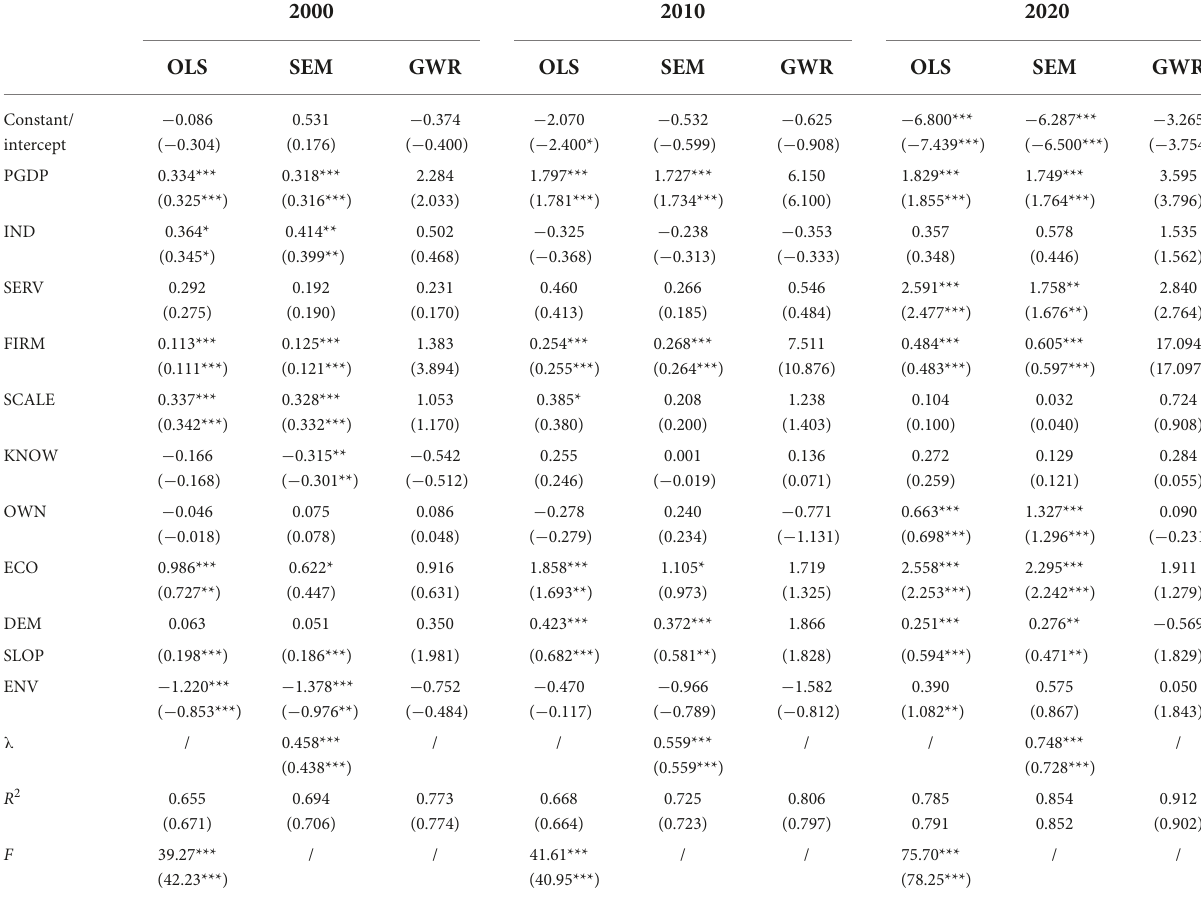
TABLE 2 Regression results of OLS, SEM, and GWR